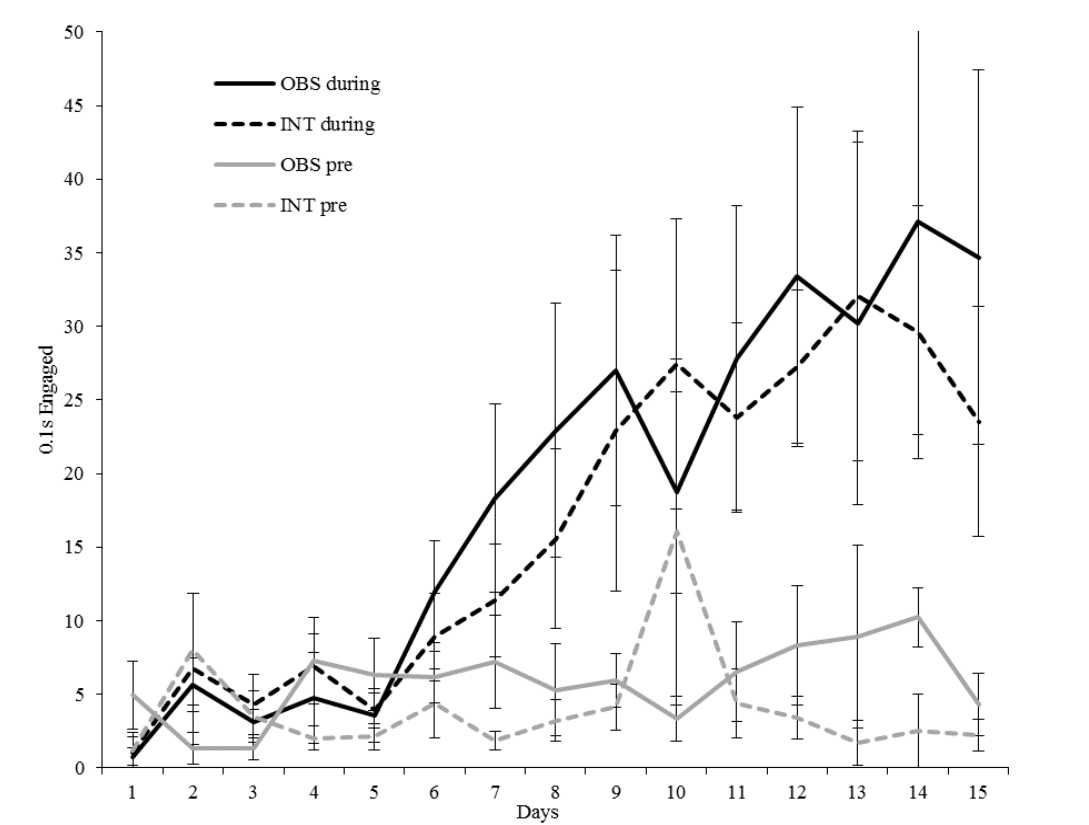
Figure 3. Nosing of the food trough by both groups, prior to and during presentations, over the 15 days of training of Experiment 3. Error bars indicate